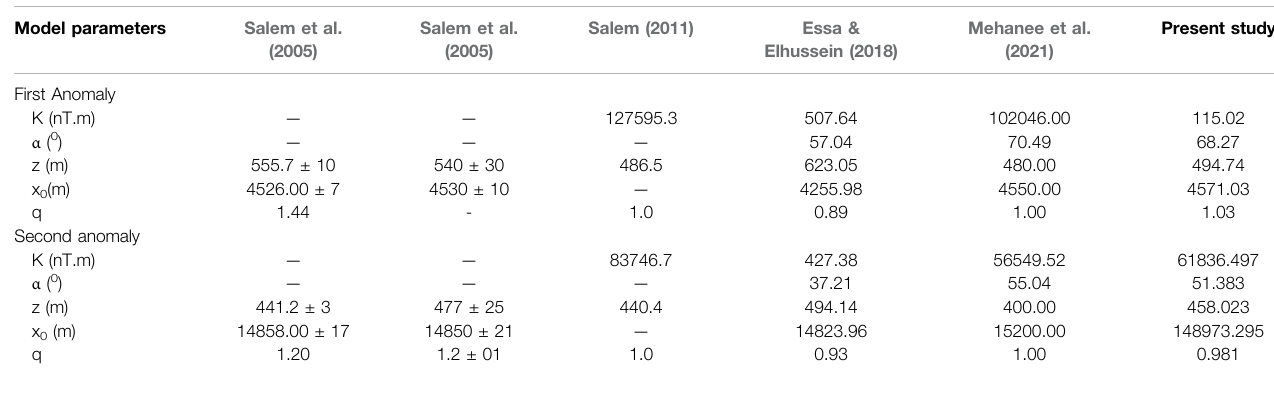
TABLE 11 | Comparative analysis of results for the Hamrawein fi eld anomaly. Model